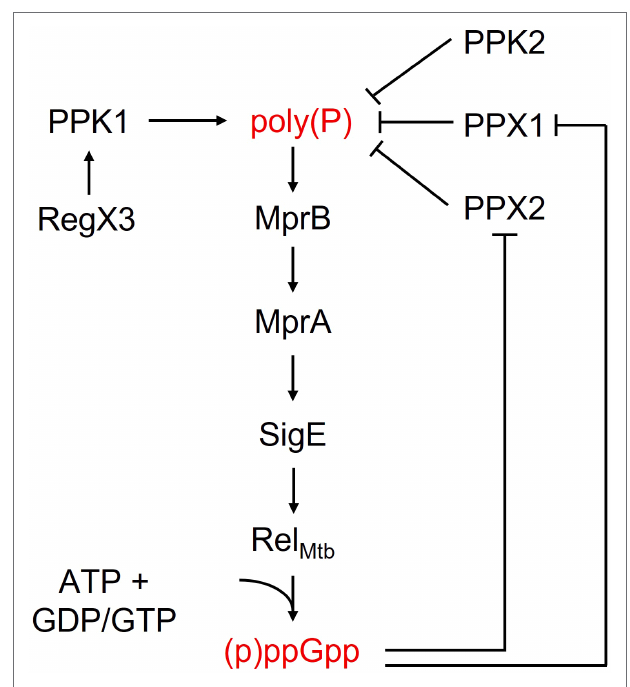
FIGURE 1 | Activity and regulation of key bacterial stringent response